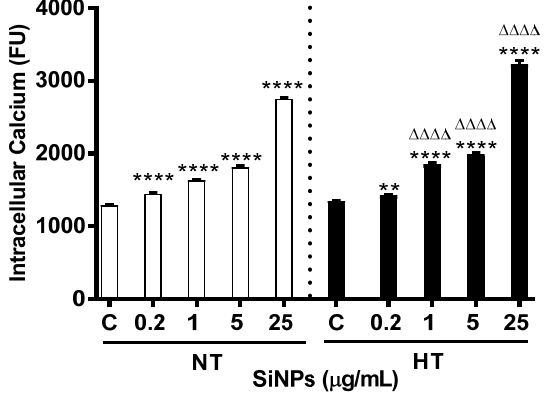
Figure 8. Effect of various concentrations ( µ g/mL) of silica nanoparticles (SiNPs) on intracellular calcium concentration measured in incubated erythrocytes of normotensive (NT) and hypertensive (HT) rats. Data are mean ± SEM ( n = 8 in each group). Statistical analysis by one-way analysis of variance (ANOVA) followed by the Holm–Sidak multiple comparisons test. ** p < 0.01, **** p < 0.0001 vs. respective control and ΔΔΔΔ p < 0.0001 vs. respective concentration in NT group.